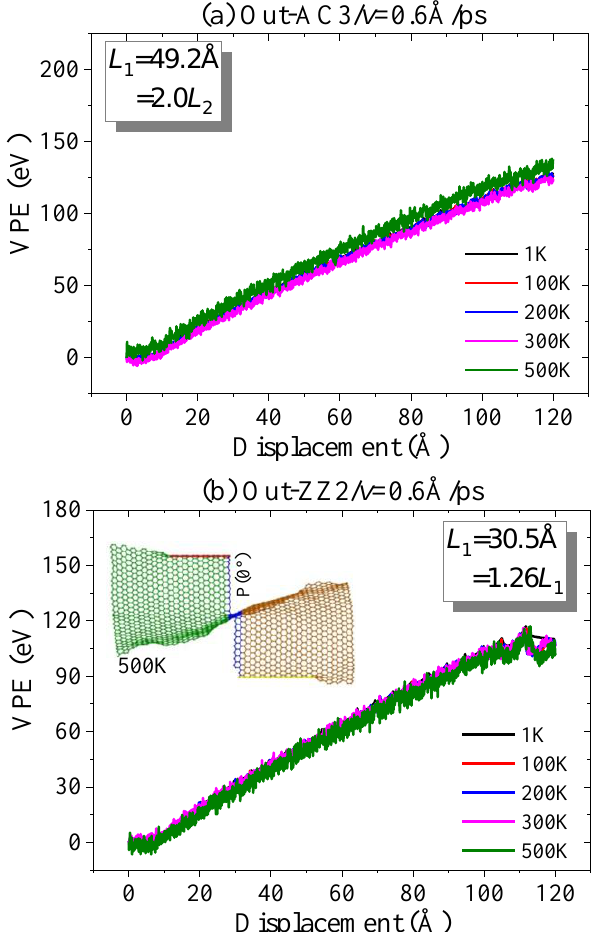
Figure 12. Curves of VPE vs. out-of-plane tearing of graphene ribbons with three aspect ratios at different temperatures: ( a ) armchair crack; ( b ) zigzag crack.